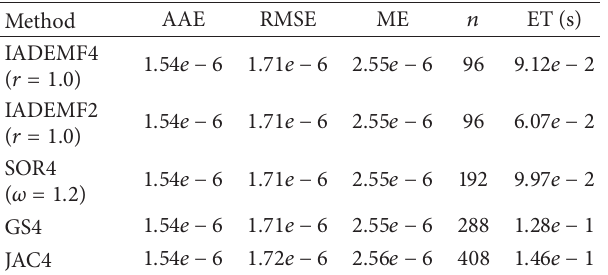
Table 5: Experiment 2. 𝑚 = 700 , 𝜆 = 1.0 , Δ𝑥 = 1.43 × 10 −3 , Δ𝑡 = 2.04 × 10 −6 , 𝑡 = 5.09 × 10 −5 , and 𝜀 = 10 −6 .